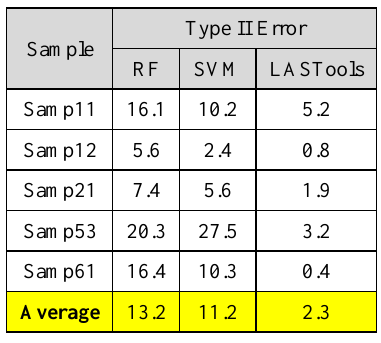
Table 2. A comparison between the accuracies obtained by the proposed method and LAStools on ISPRS dataset.